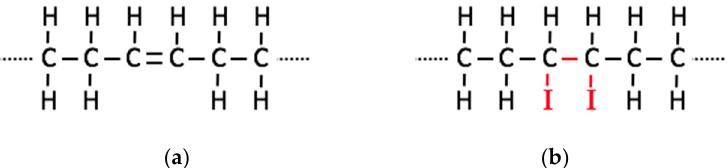
Figure 8. Partial carbon-hydrogen chain showing a double bond ( a ) and the inclusion of two iodine atoms ( b